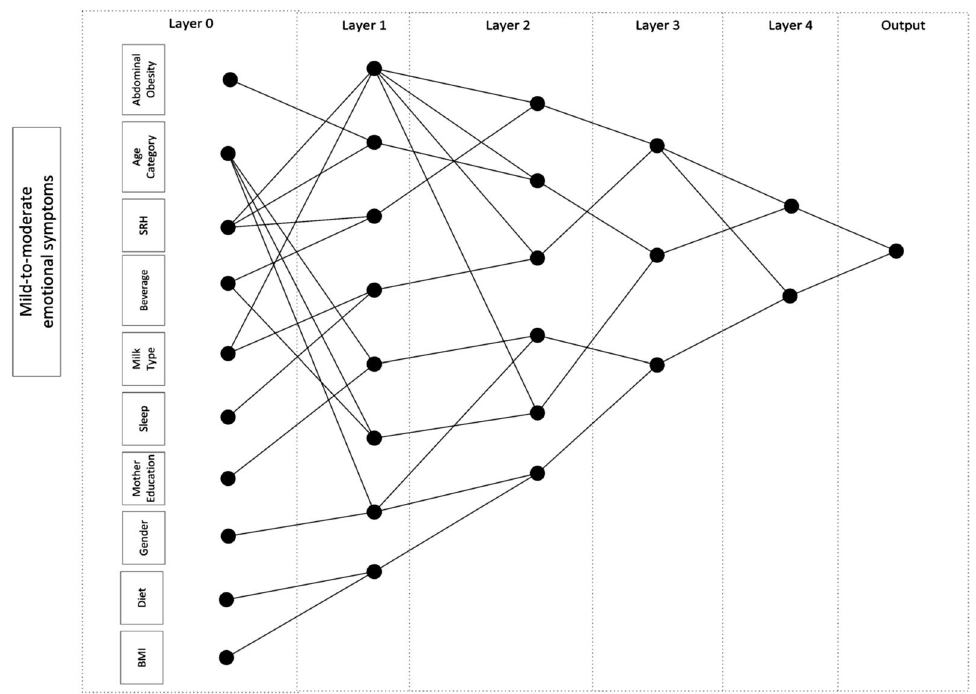
Figure 3. A representative GMDH network for classifying mild-to-moderate emotional symptoms.